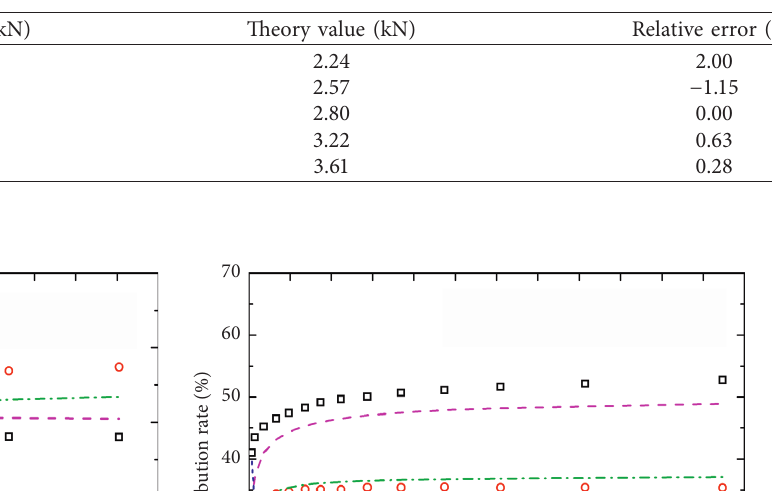
Table 6: Error analysis of the ultimate bearing